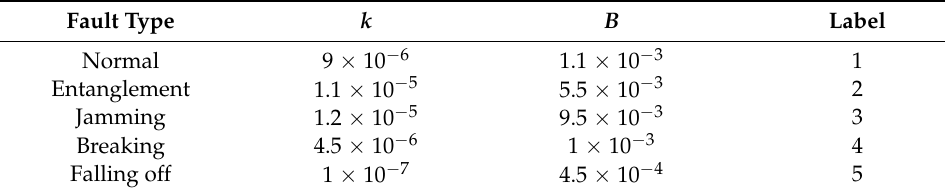
Table 5. Fault characteristics parameters of the thrusters (test set).